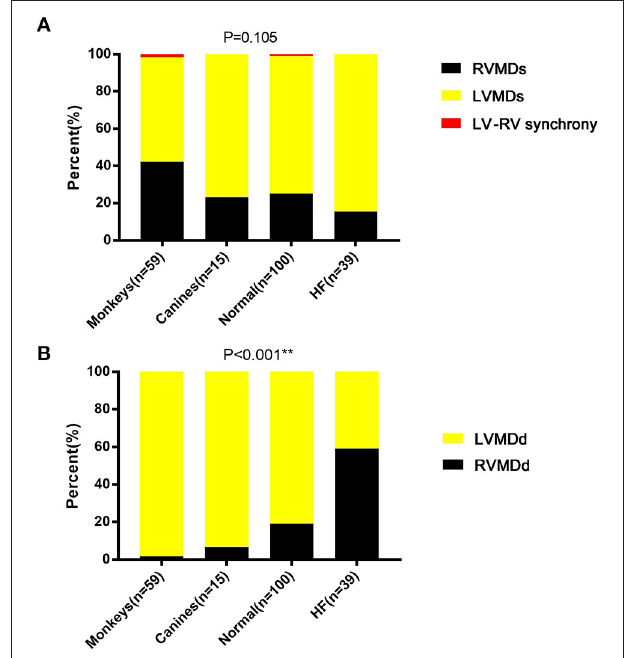
FIGURE 4 | Ventricular mechanical sequences in (A) systole and (B) diastole. LVMDs, left ventricular mechanical delay in systole; LVMDd, left ventricular mechanical delay in diastole; RVMDs, right ventricular mechanical delay in systole; RVMDd, right ventricular mechanical delay in diastole. **denotes results satisfying the significance criterion p <